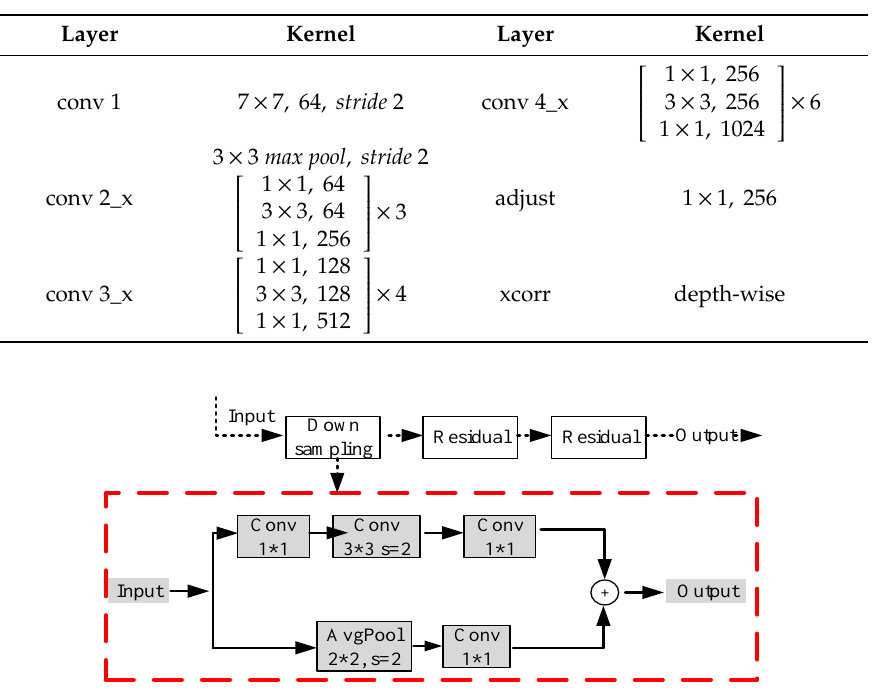
Figure 9. The improved down-sampling block employed in the Resnet network.